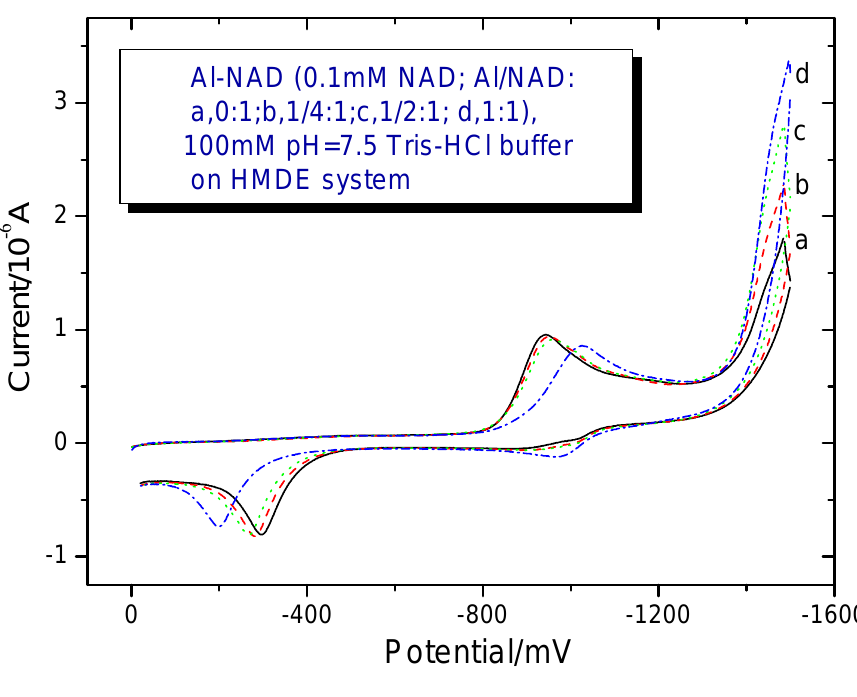
Figure 3. The cyclic voltammogram of NAD + and Al-NAD + ; in 100mM pH=7.5 Tris-HCl buffer solution; 0.1 mM NAD + ; Al/L: a, 0:1;b, 1/4:1;c, 1/2:1; d, 1:1, on a three-electrode system